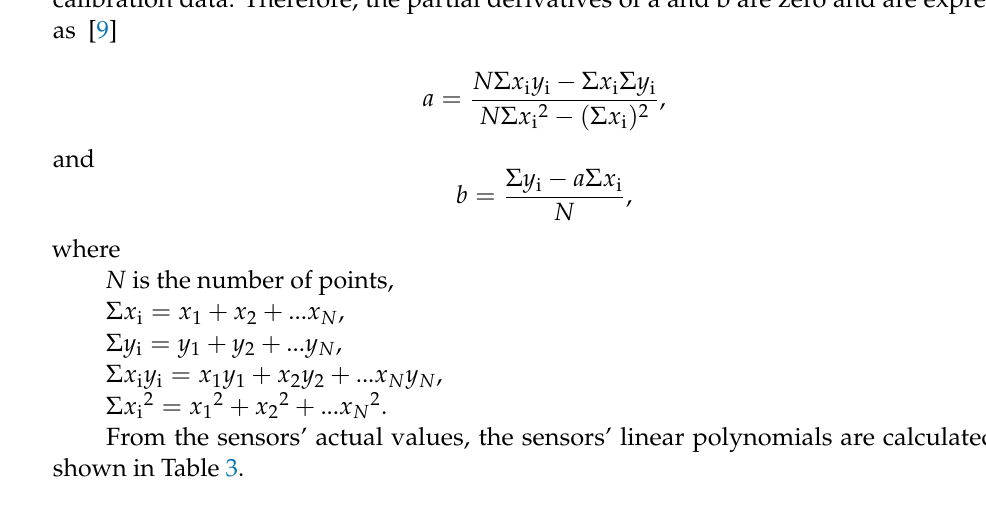
Table 3. Linear polynomial values of the proposed sensor. Linear Polynomial SSE R 2 RMSE